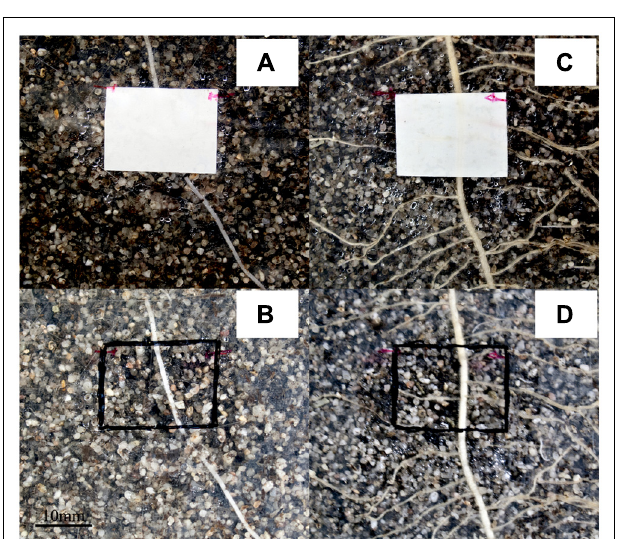
FIGURE 2 | Photographs of the experimental setup as seen through the transparent window of the rhizotrons with and without optodes installed .The pictures show roots growing with no neighbor of another species nearby. Panels (A,B) are photographs of maize roots while (C,D) are of bean roots. Panels (A,C) were shot at the time of destructive harvesting which corresponded to DAT 14 (DAT, days after transplanting) and we can clearly see the roots crossing the planar optodes.The optodes where removed as seen in (B,D) to precisely locate the root trajectories under the sensors.The scale is given by the optodes which measure 10 mm × 20 mm regions of interest